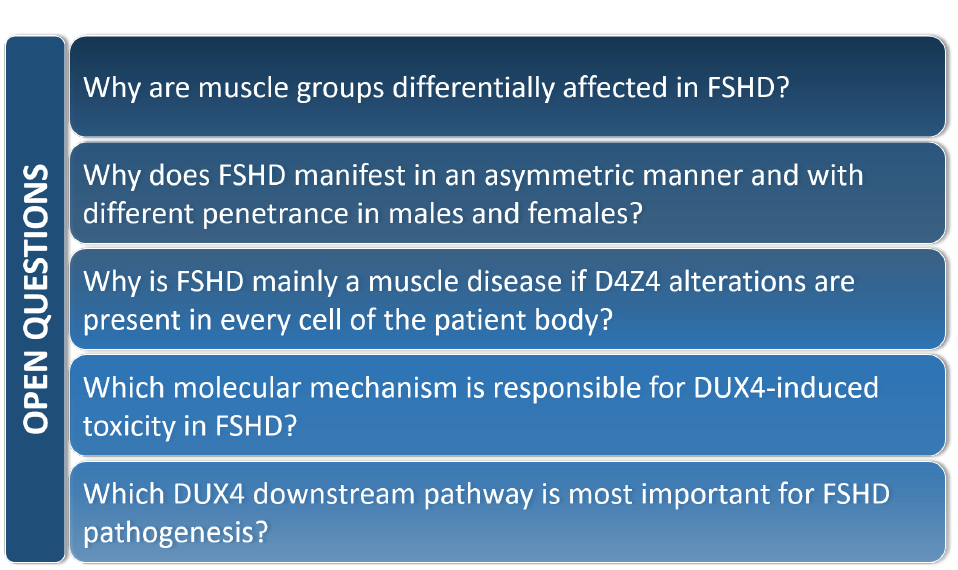
Figure 5. Relevant open questions in the FSHD field.